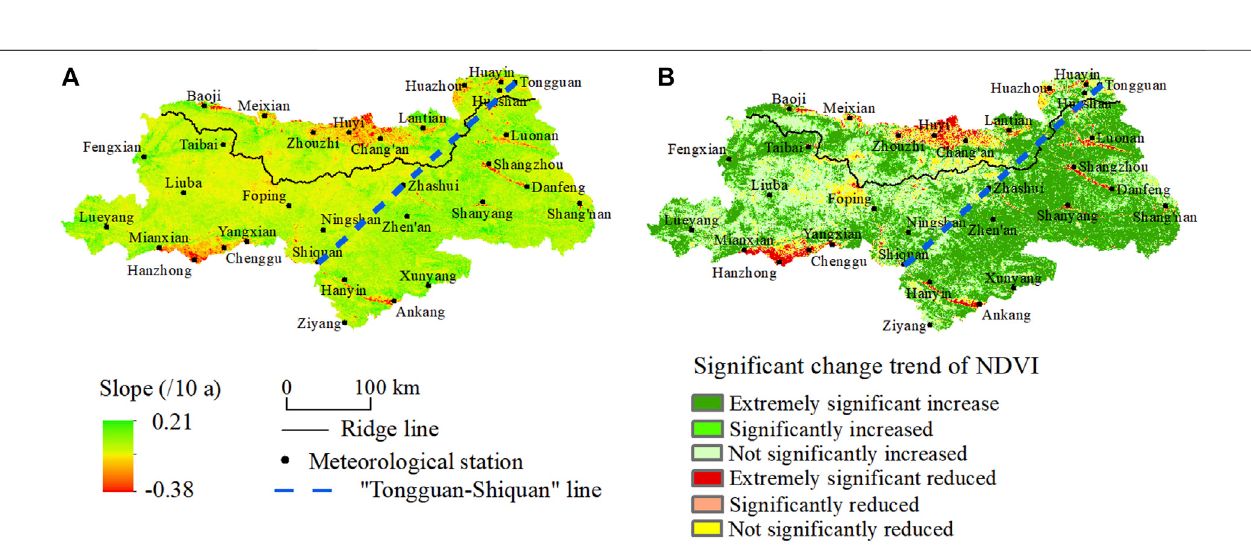
Frontiers in Earth Science |